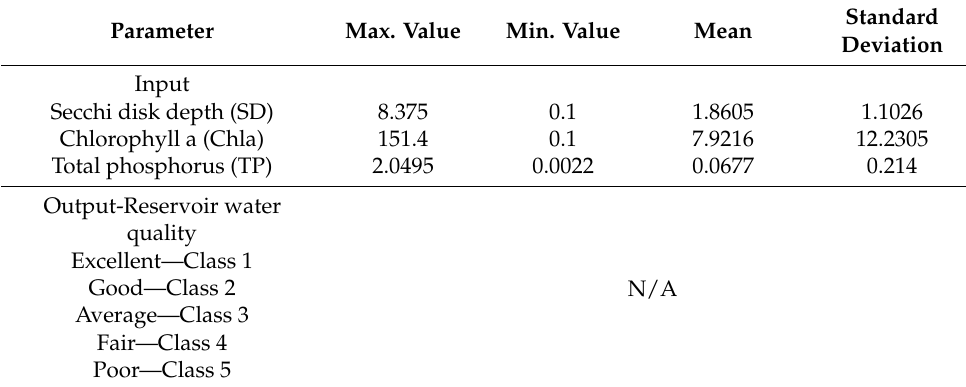
Table 8. Statistical attributes of reservoir water quality dataset.